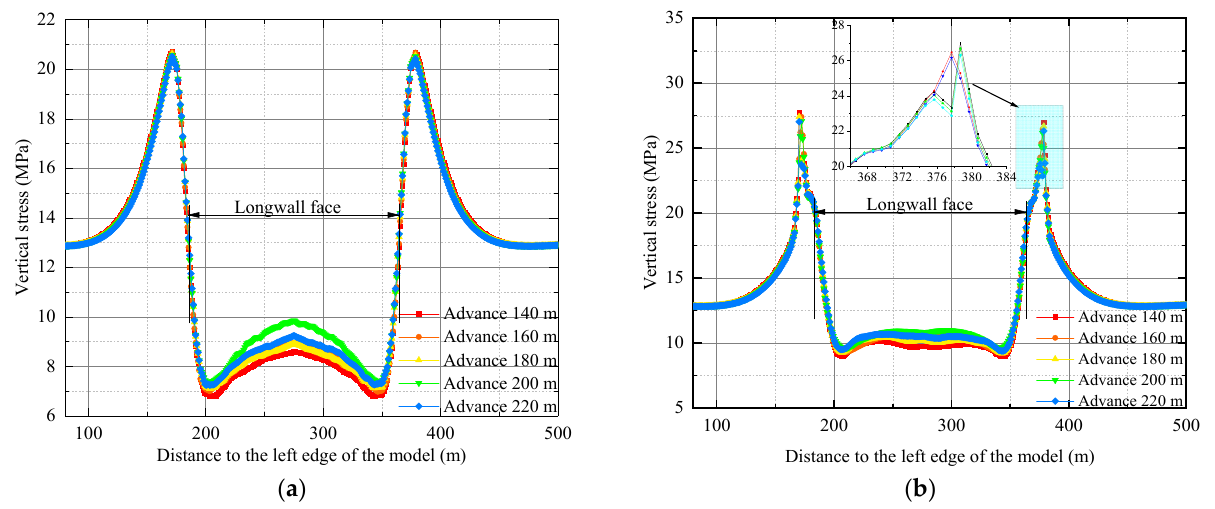
Figure 5. Vertical stress distribution curve (cross-section of 10 m in advance of the longwall face). ( a ) Base model; ( b ) Graben fault model.